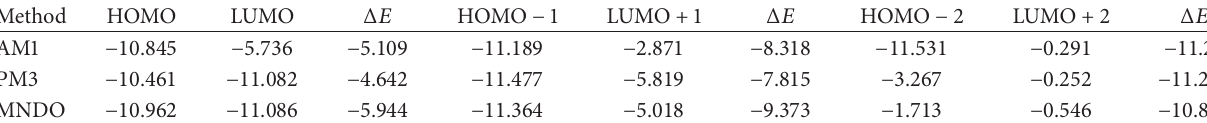
Table 3: HOMO and LUMO energies (eV) of 5-chlorocurcumin.